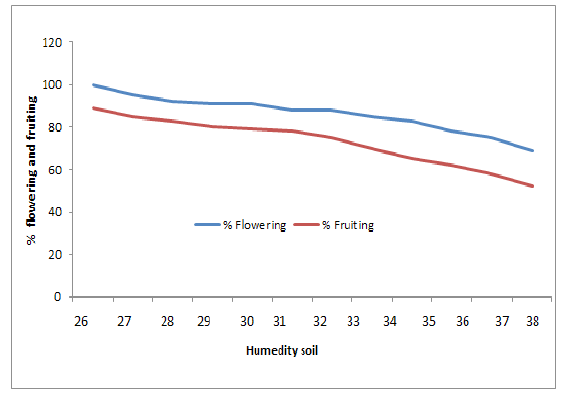
Figure 8. Percentage of flowering and fruiting in relation to soil moisture.